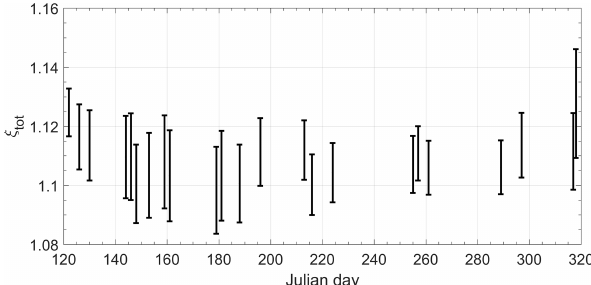
Figure 11. Time series of the total cross-talk factor ξ tot measured in 2017. The vertical bars show the uncertainty in the retrieval, which includes the statistical error from the determination of the interchan- nel constants and systematical errors from the value considered in the molecular region 0005 ±